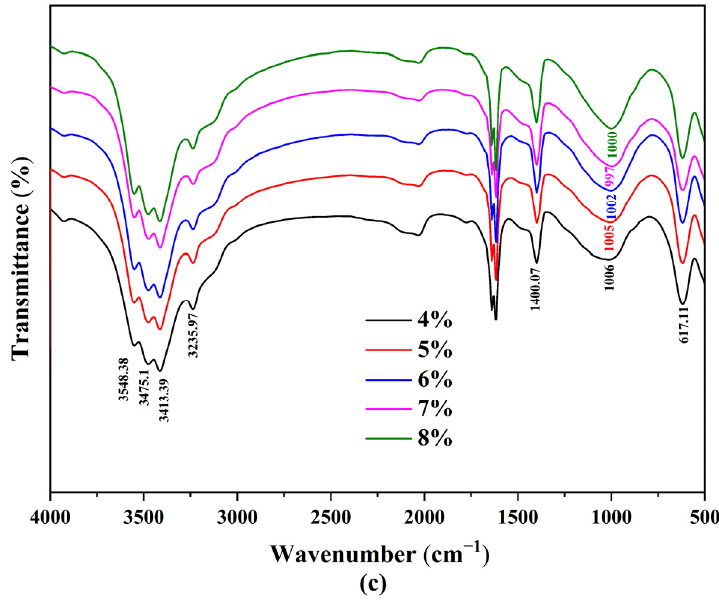
Figure 9. FTIR spectra of the slag-based geopolymer paste with different alkali contents at the age of ( a ) 4 h, ( b ) 24 h, and ( c ) 7 days.